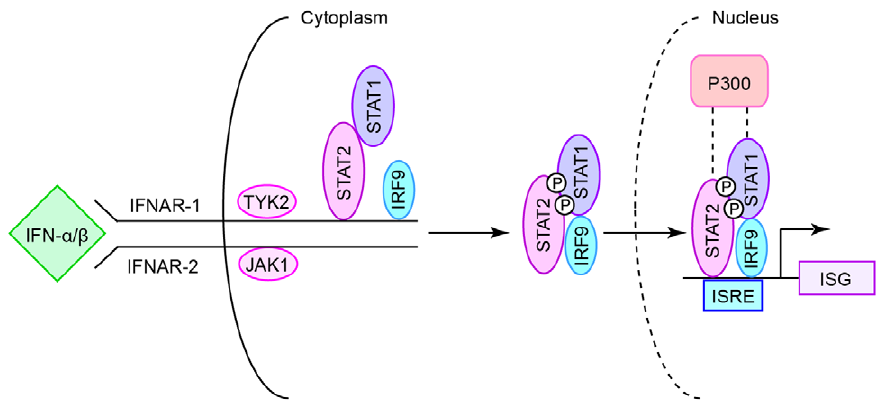
Figure 1. Scheme for IFN signal transduction. Type I IFN signaling starts by activation of the IFN- a / b receptor (IFNAR) and subsequent activation of the IFNAR1-associated TYK2 and IFNAR2-associated JAK1, with consequent recruitment of STAT2. Phosphorylation of STAT2 enables reruitment of STAT1 and release of the phosphorylated STAT1-STAT2 heterodimer bound to IRF-9. This complex binds to the IFN stimulated response element (ISRE) and in concert with recruited transcriptional co-activators such as p300/CBP then drives IFN-stimulated gene (ISG) transcription.